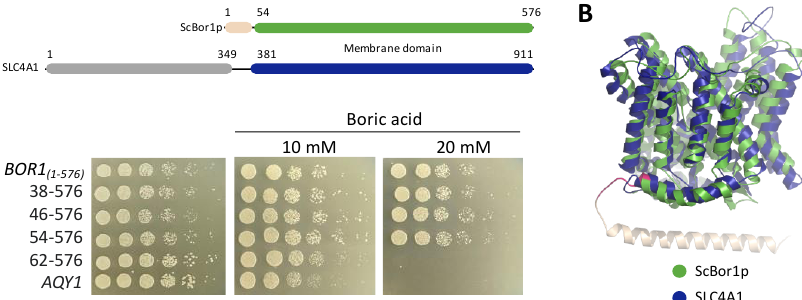
Figure 1. An N-terminal region is dispensable for ScBor1p function. ( A ) Schematic showing the domain arrangements of ScBor1p and human SLC4A1. The membrane domains are in green and blue, respectively. SLC4A1 cytosolic ankyrin-binding domain is in gray. ( B ) Superposition of a cryoEM structure of the membrane domain (blue) of human SLC4A1 (PDB ID: 8CT3) [14] and the AlphaFold model of ScBor1p (green) rendered in PyMOL with RMSD = 2.993 Å. The dispensable region of the N-terminal tail is tan; the region that results in no function when deleted is pink and marks the beginning of helix H1. ( C ) Plasmids encoding the specified ScBor1p truncated construct or negative control AQY1 were transformed into bor1 deletion cells and the ability of each to rescue growth was tested by plating fivefold serial dilutions onto plates containing CSM-His selective media and the indicated boric acid concentrations. Plates were incubated at 30 ◦ C and imaged after 5